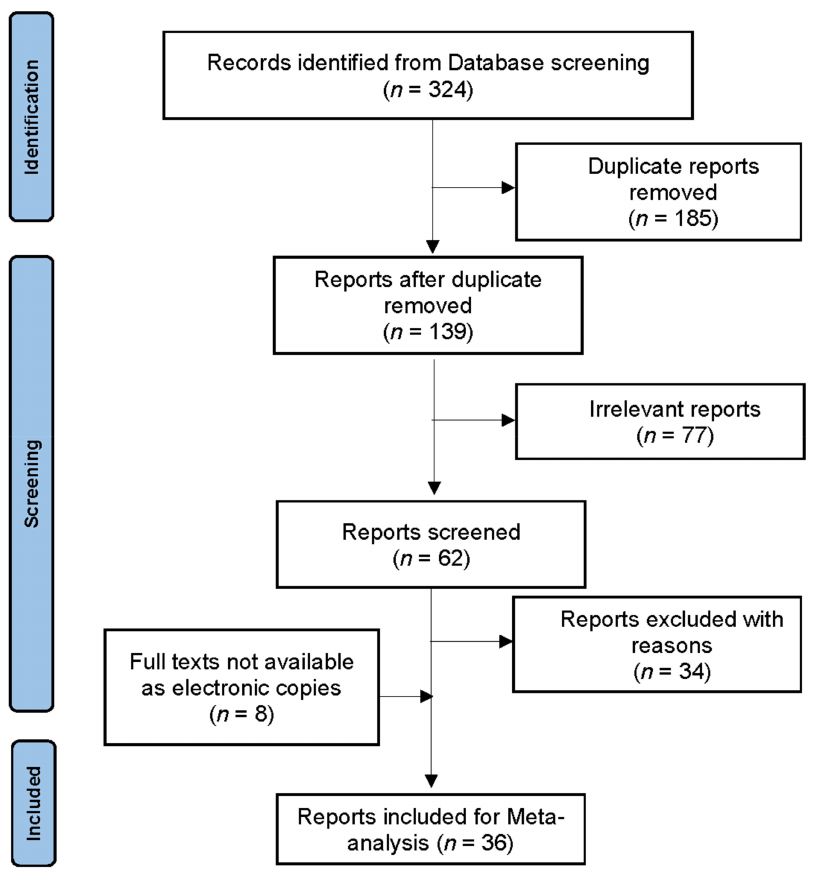
Figure 1. Flow diagram established according to PRISMA guidelines and showing methodologies of databases search and selection of eligible